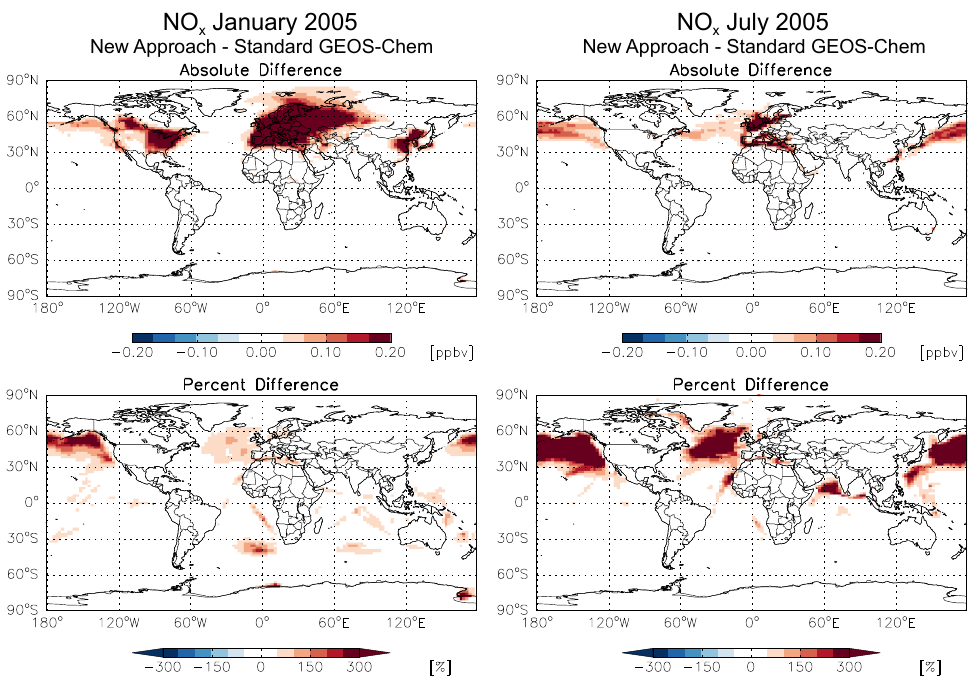
Fig. 8. Differences between standard GEOS-Chem and plume-in-grid simulations of NO x concentrations in January and July 2005. Results Fig. 8. Difference plots between monthly mean global NO x concentrations simulated with GEOS-Chem are shown for the lowest GEOS-Chem model layer (0–0.12km). for January and July 2005 for the standard GEOS-Chem model and the new LUT approach model simu- lations, for the lowest model layer (0–0.12 km).